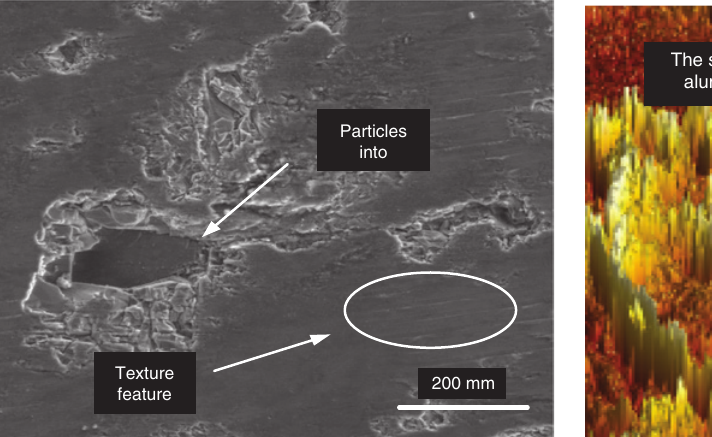
Figure 3: Surface grains and texture features.